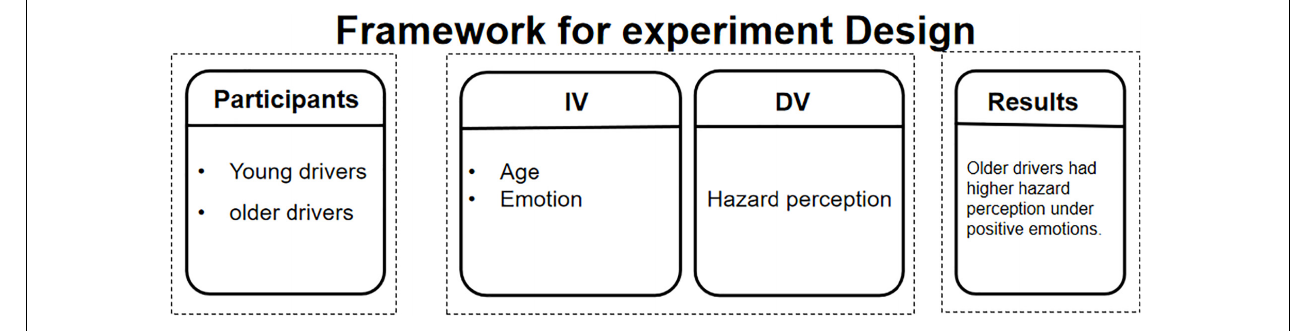
FIGURE 1 | Framework for experiment design.